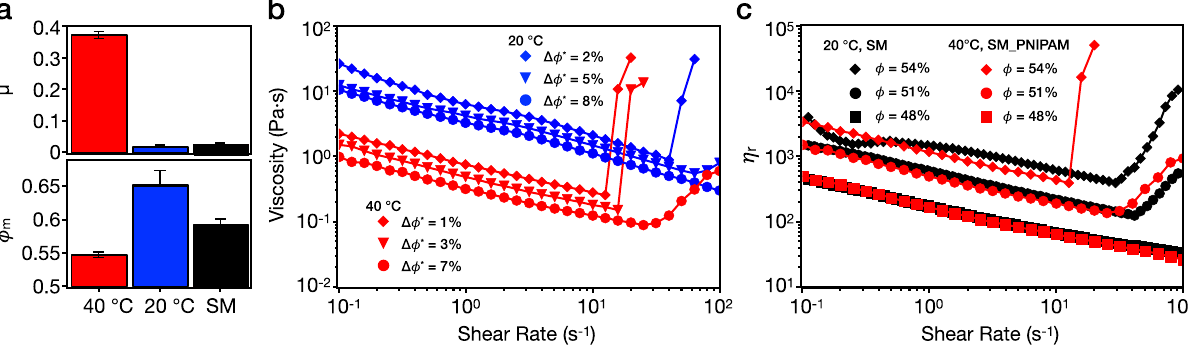
Fig. 3 Rheology experiments on PNIPAM-grafted smooth particles. a Friction coef fi cients μ (top) and frictional packing fraction ϕ m (bottom) of the SM_PNIPAM system at 40 °C (red) and 20 °C (blue) and SM system (black). Error bars in μ represent the uncertainties in the calculated slope based on Eq. (1). μ of SM_PNIPAM at 20 °C was calculated from 10 to 30 nN. Error bars in ϕ m represent the standard deviations from four repeat measurements. b Rheological fl ow curves of SM_PNIPAM in rescaled packing fractions Δ ϕ * at 20 °C (blue) and 40 °C (red). c Normalized fl ow curves of SM_PNIPAM at 40 °C (red) and SM at 20 °C (black) for ϕ = 48, 51, and 54%. The relative viscosity η r is calculated based on η r = η measured / η water ( T ). The results for the SM system are adapted from previous work 26